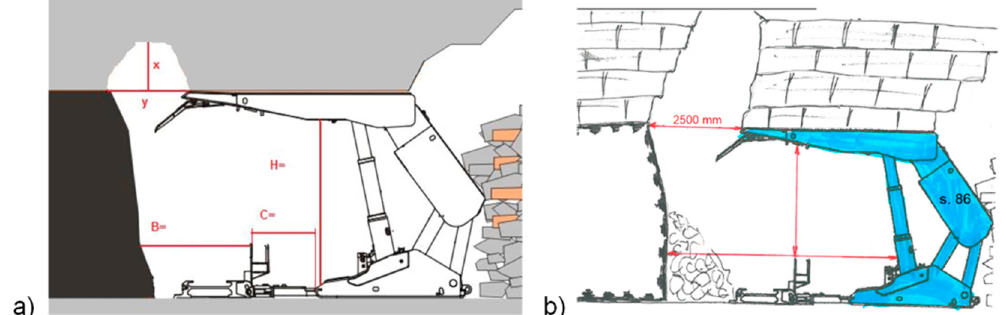
Figure 3. Geometric parameters of the roof fall in the working of a longwall: ( a ) measurement sketch, ( b ) situation sketch in the longwall working during roof fall (Source: Own elaboration).